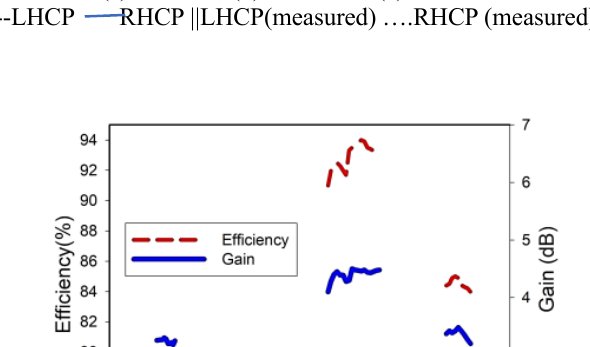
Figure 9.: Radiation patterns obtained for the two orthogonal planes on simulation and measurement of the proposed antenna at: (a) 1.5 GHz, (b) 2.75 GHz, (c) 3.16 GHz (--LHCP